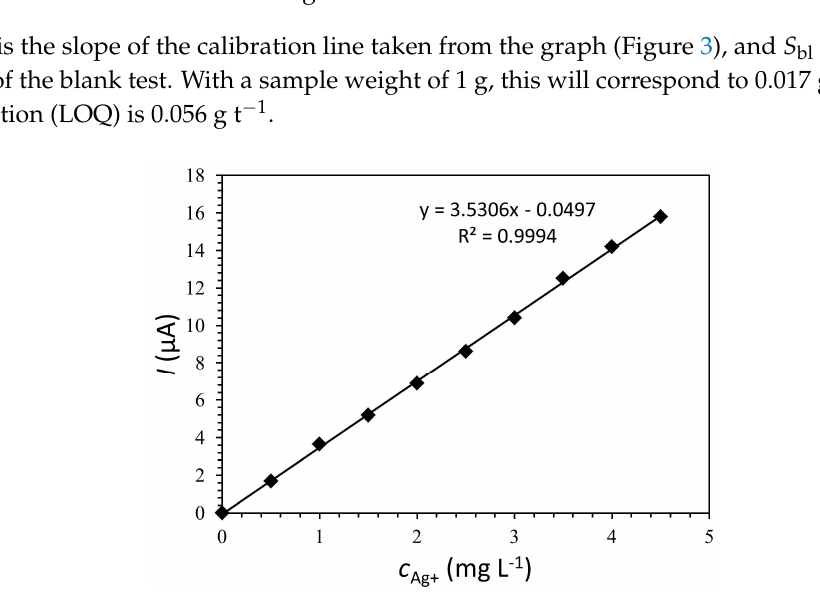
Figure 3. The dependence of the peak current of silver electrooxidation on the concentration of silver(I) ions in the solution. Experimental conditions: medium of 1 mol L − 1 HCl + NH 4 OH up to pH = 6.5, E e = − 0.7 V; τ e = 120 s; v = 0.06 V s − 1 ; and c Ag+ = 0.5–4 mg L − 1 .